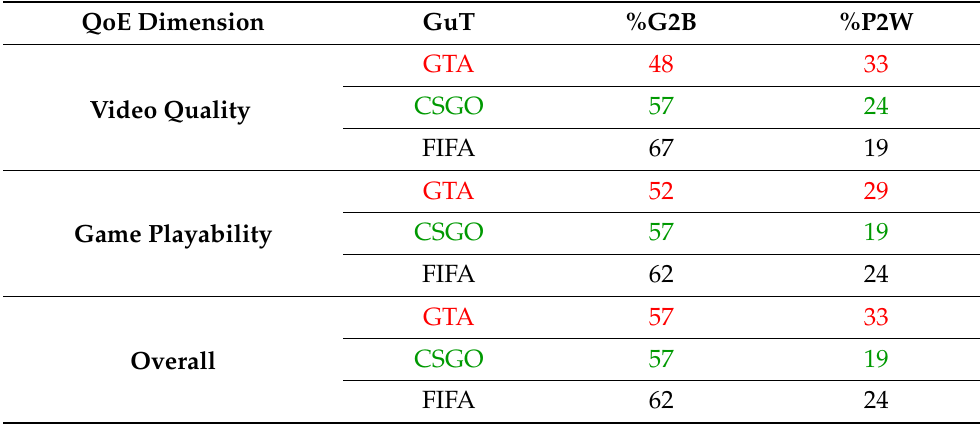
Table 3. Summary of %G2B and %P2W of different QoE dimensions for GuT. QoE Dimension